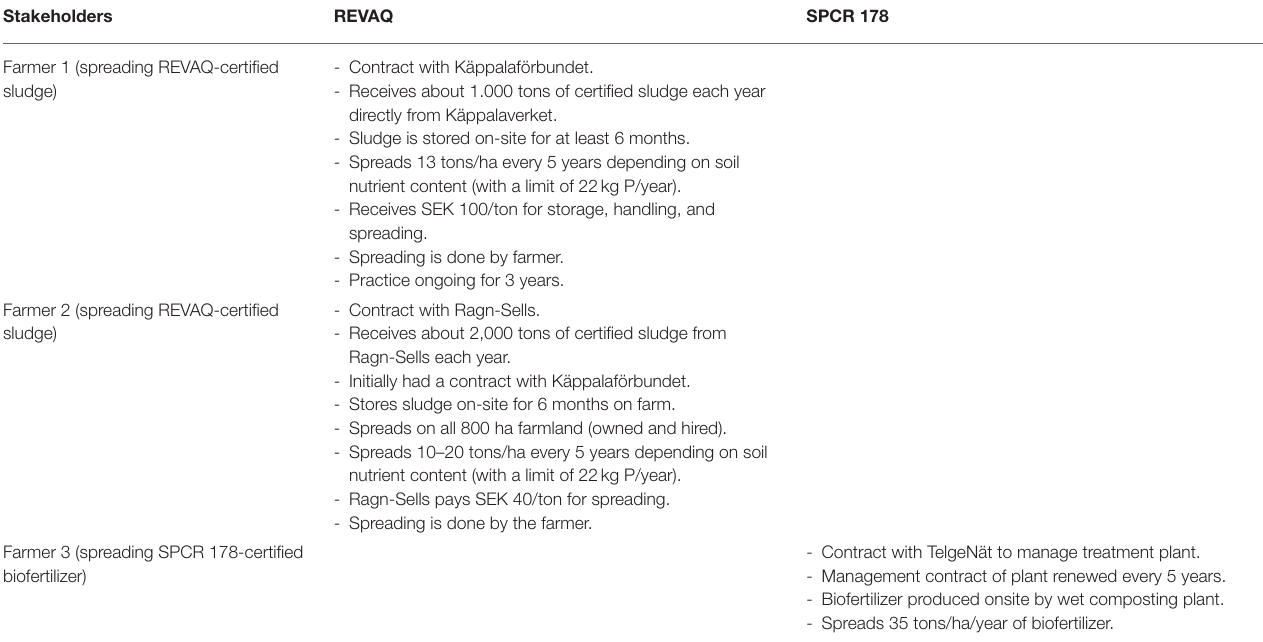
TABLE 5 | Different arrangements in the certification systems.